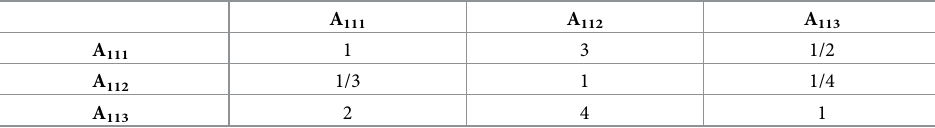
Table 8. Pairwise comparison matrix of the brownfield pollution control indexes.